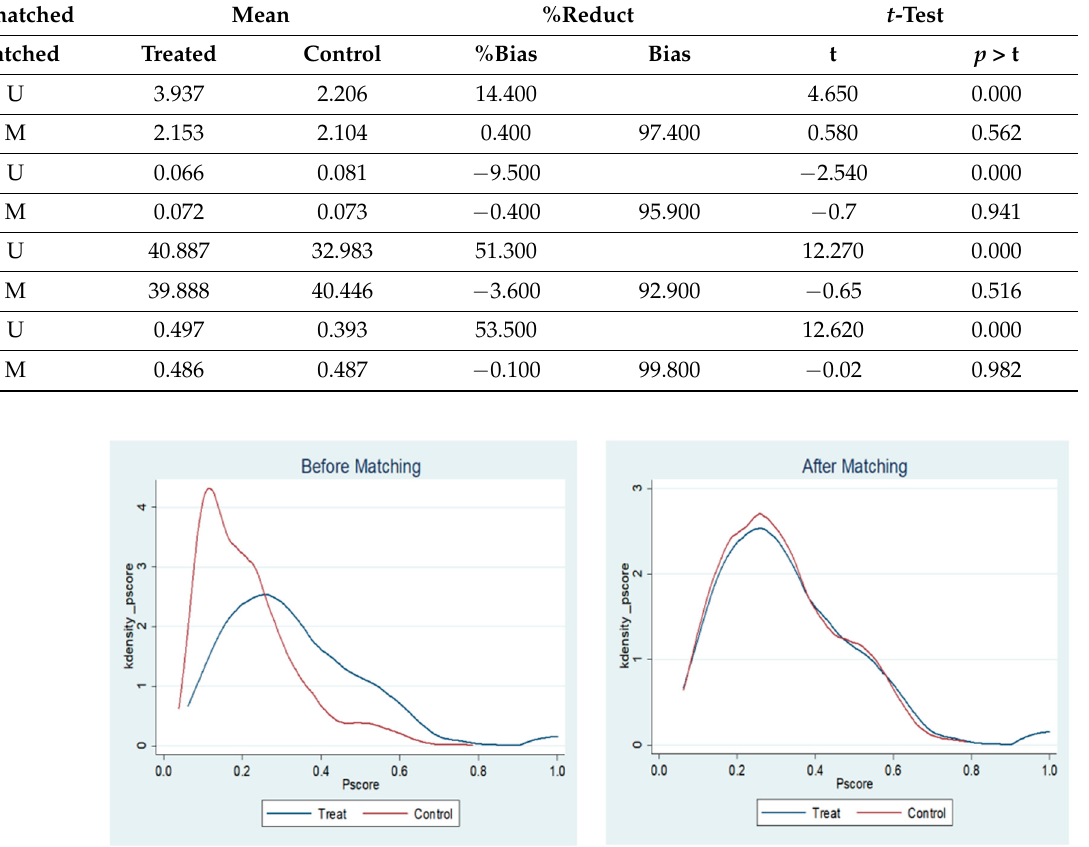
Table 3. The PSM validity test.